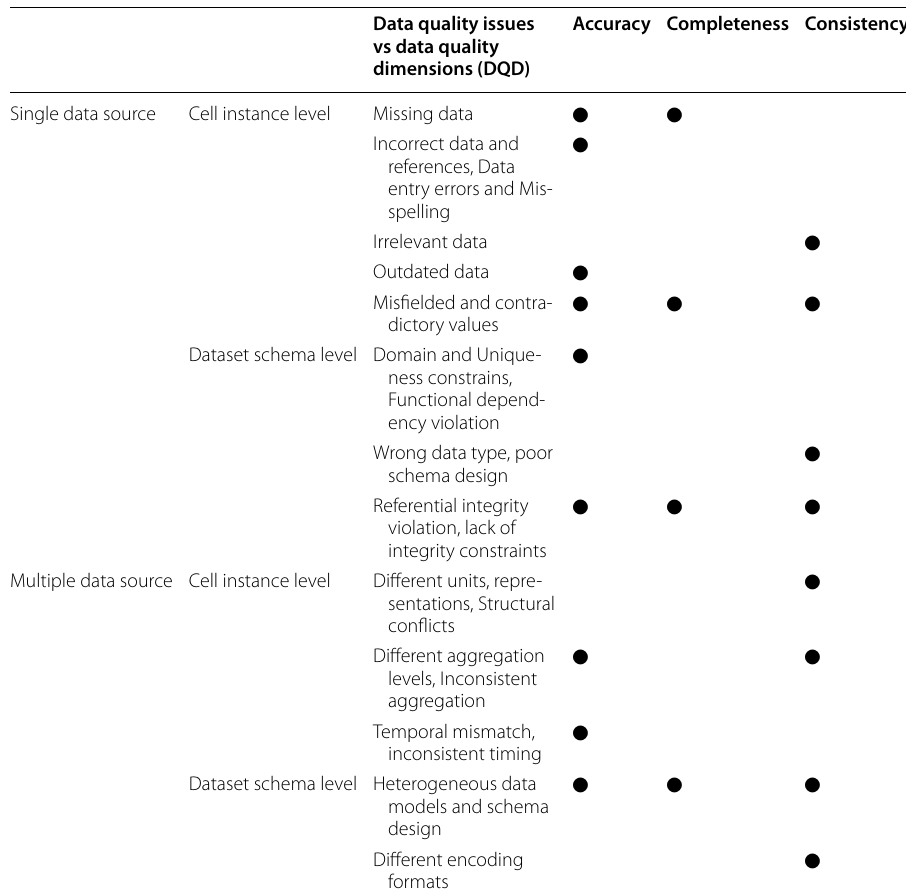
Table 4 Example of data quality